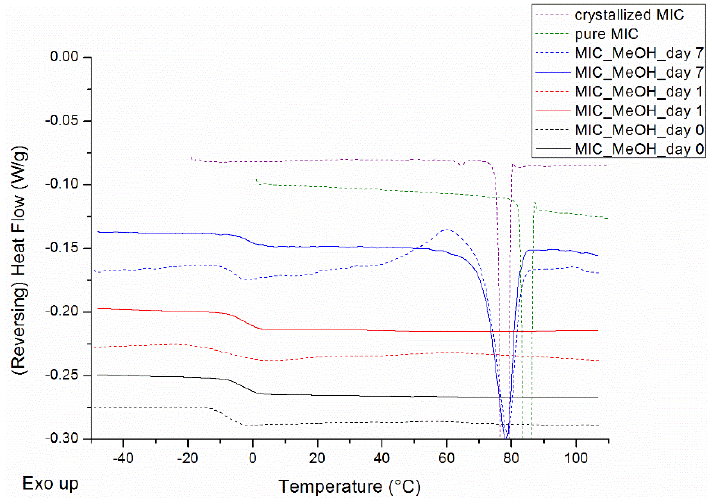
Figure 1. Modulated differential scanning calorimetry (mDSC) thermograms of spray dried miconazole (MIC) in methanol (MeOH), right after spray drying (black), after 1 day (red) and after 7 days (blue) of storage, and the mDSC thermogram of pure MIC (green), i.e., polymorph I, and the mDSC thermogram of MIC crystallized from a saturated MeOH solution (purple) as comparison.